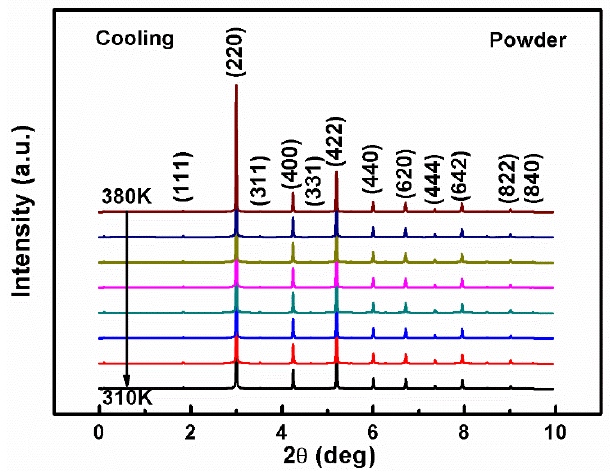
Figure 4. High-energy X-ray diffraction patterns collected during cooling from 380 K to 310 K for the Ga22-4 ( x = 5.5) alloy. Ga22-4 ( x = 5.5)